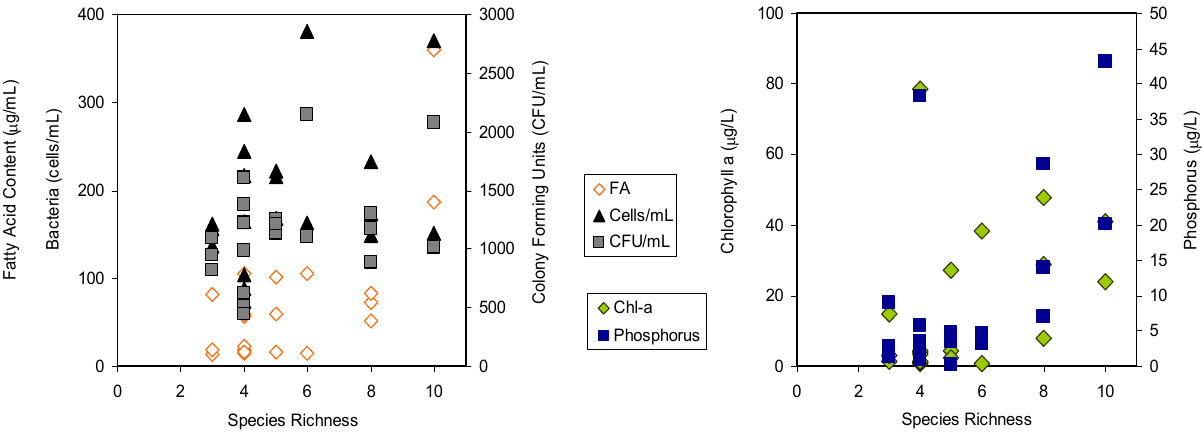
Figure 3. Relationships between bacterial species diversity as the total number of species identified in each pond (species richness) using cultivation techniques and (left panel) colony forming units (CFU/mL), bacterial cell abundance determined by microscopy (cells/mL) and total FA content of seston; and (right panel) chlorophyll- a and dissolved phosphorus (P) concentration in pond